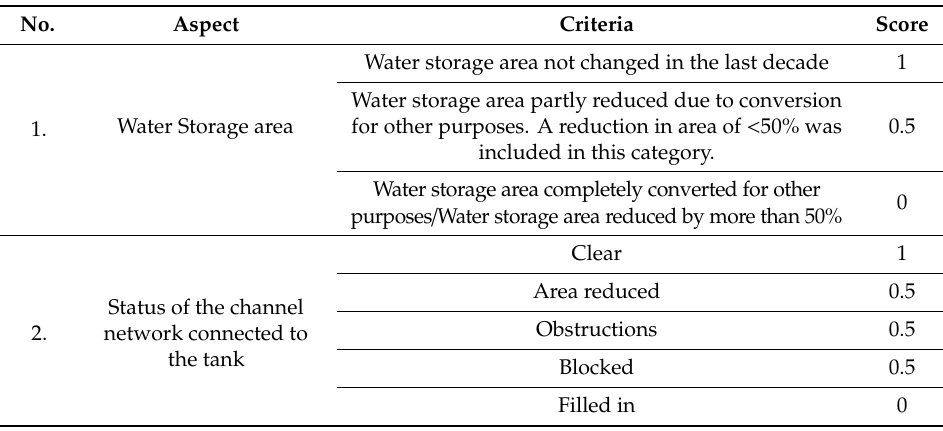
Table A1. Tank system status—scoring